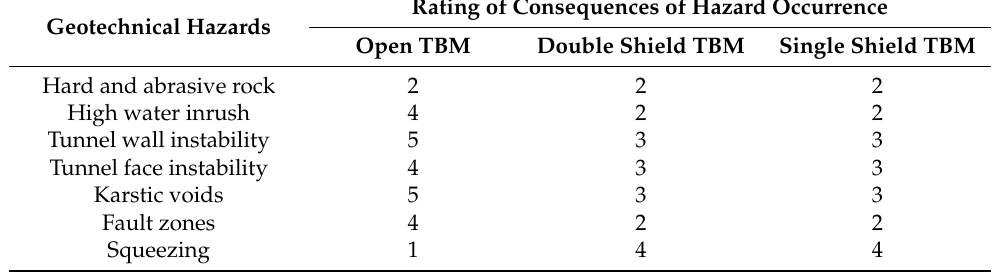
Table 21. Rating of consequences of hazard occurrence.